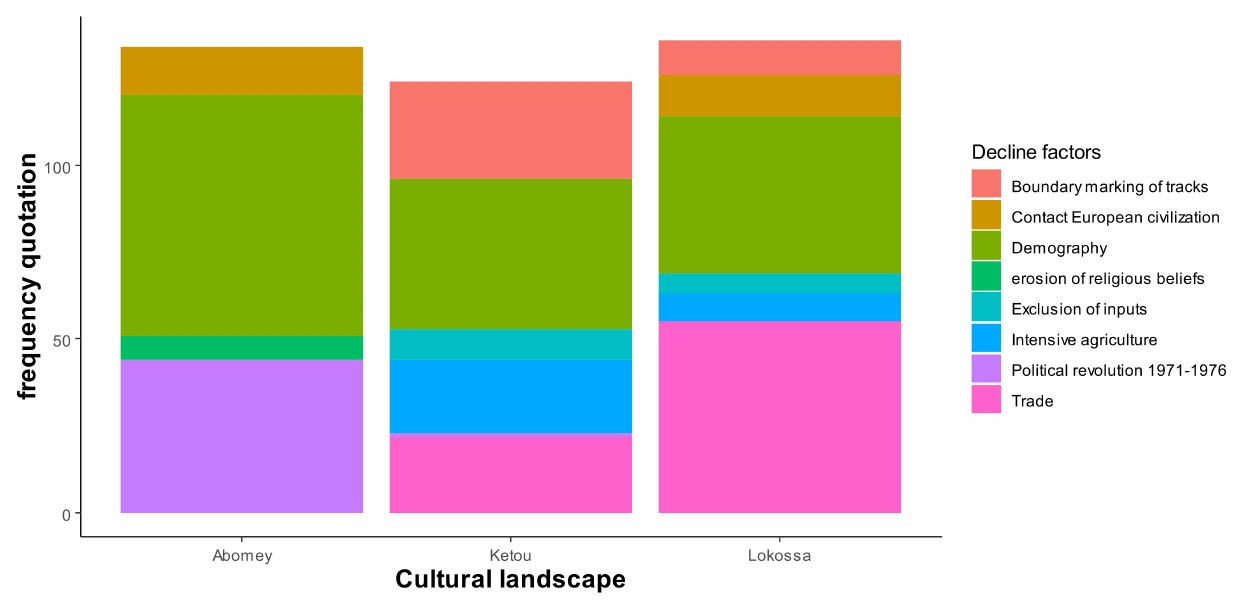
Figure 11. Decline factors of LOTs according to cultural